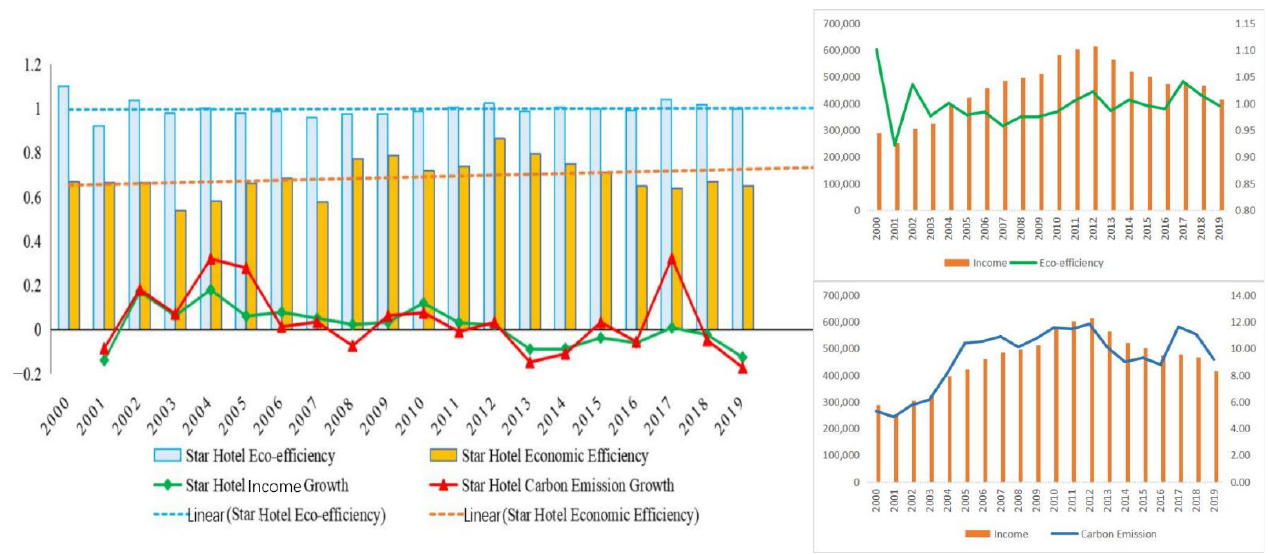
Figure 3. Overall trends in the eco-efficiency and economic efficiency of tourist hotels, 2000–2019.